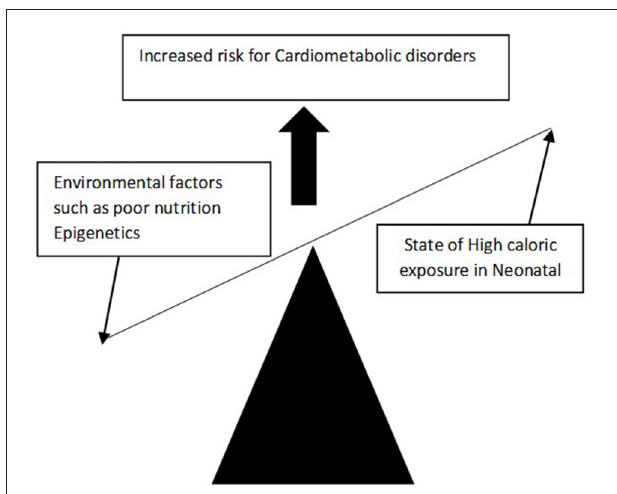
FIGURE 1 | Barker’s